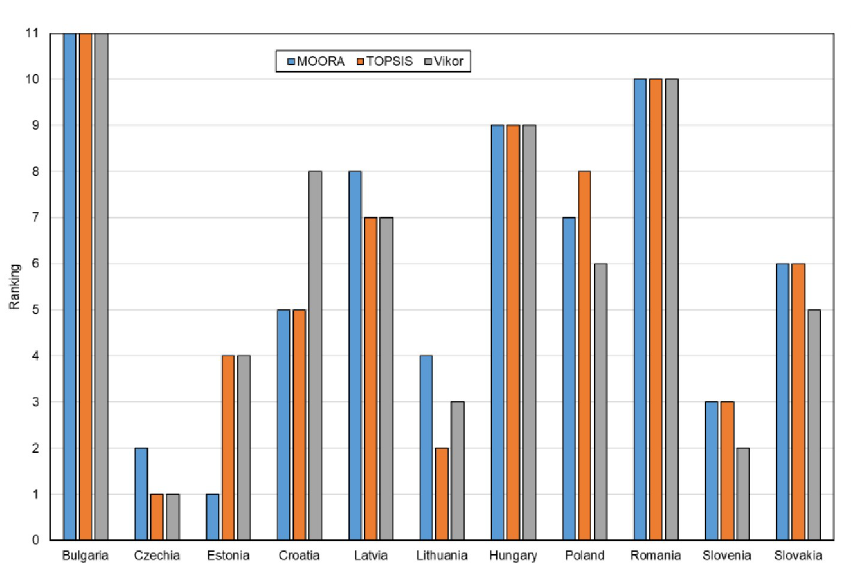
Fig 6. Classification (ranking) of the CEE countries in terms of digital maturity among manufacturing companies using the MOORA, TOPSIS and VIKOR methods.